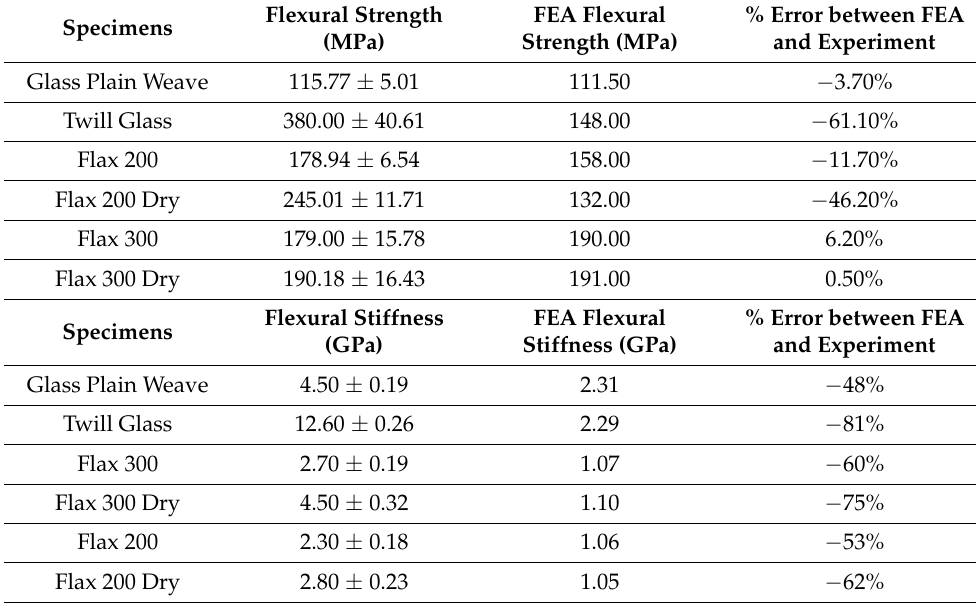
Table 5. Experimental and FEA data for the composite